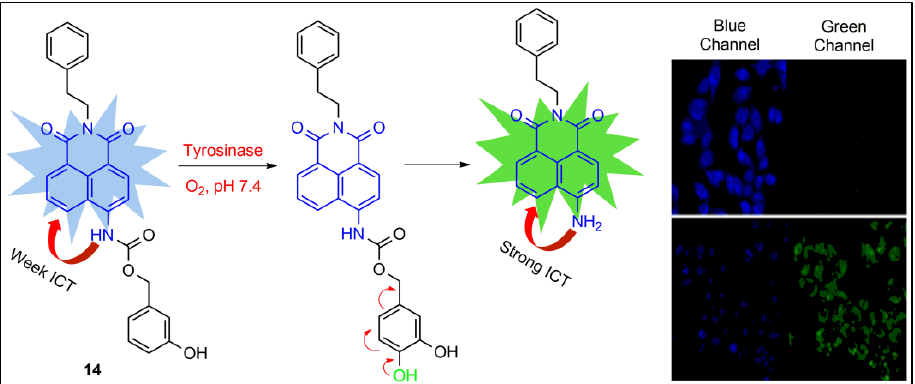
Figure 14. Tyrosinase detection strategy. Fluorescence images of A375 after 30 min of incubation with probe 14 (upper panel). Cells exhibit strong blue emissions compared to green channel suggesting that the probe was not significantly catalyzed by endogenous tyrosinase. After 3 h of incubation (lower panel), green emissions of A375 enhanced prominently while blue emissions quenched significantly. Green emissions indicate the endogenous catalysis of probe 14 . Adapted with permission from [76]. Copyright (2018) The Royal Society of Chemistry.